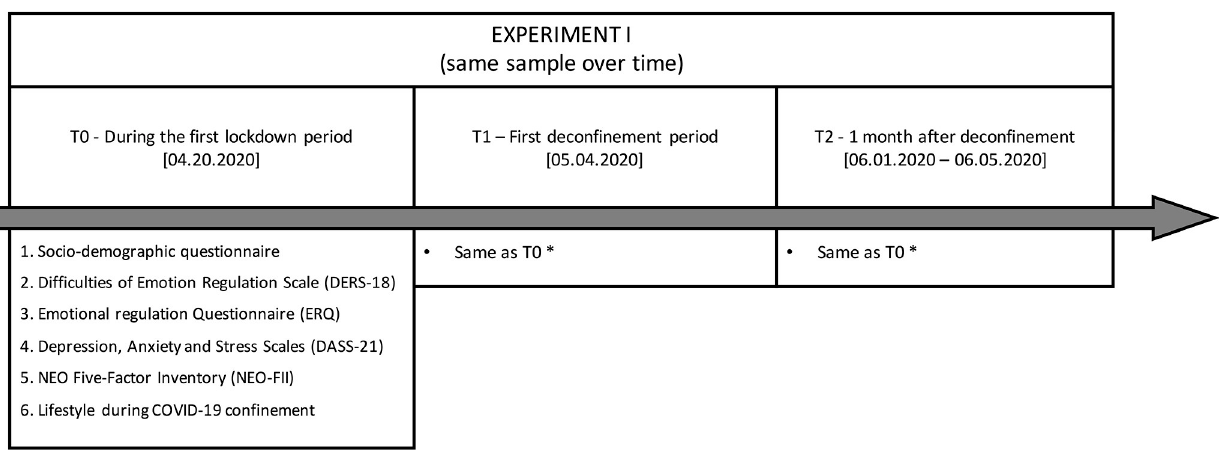
Fig 1. Schematic representation of Experiment I. � Except for NEO Five-Factor Inventory and socio-demographic questionnaire.